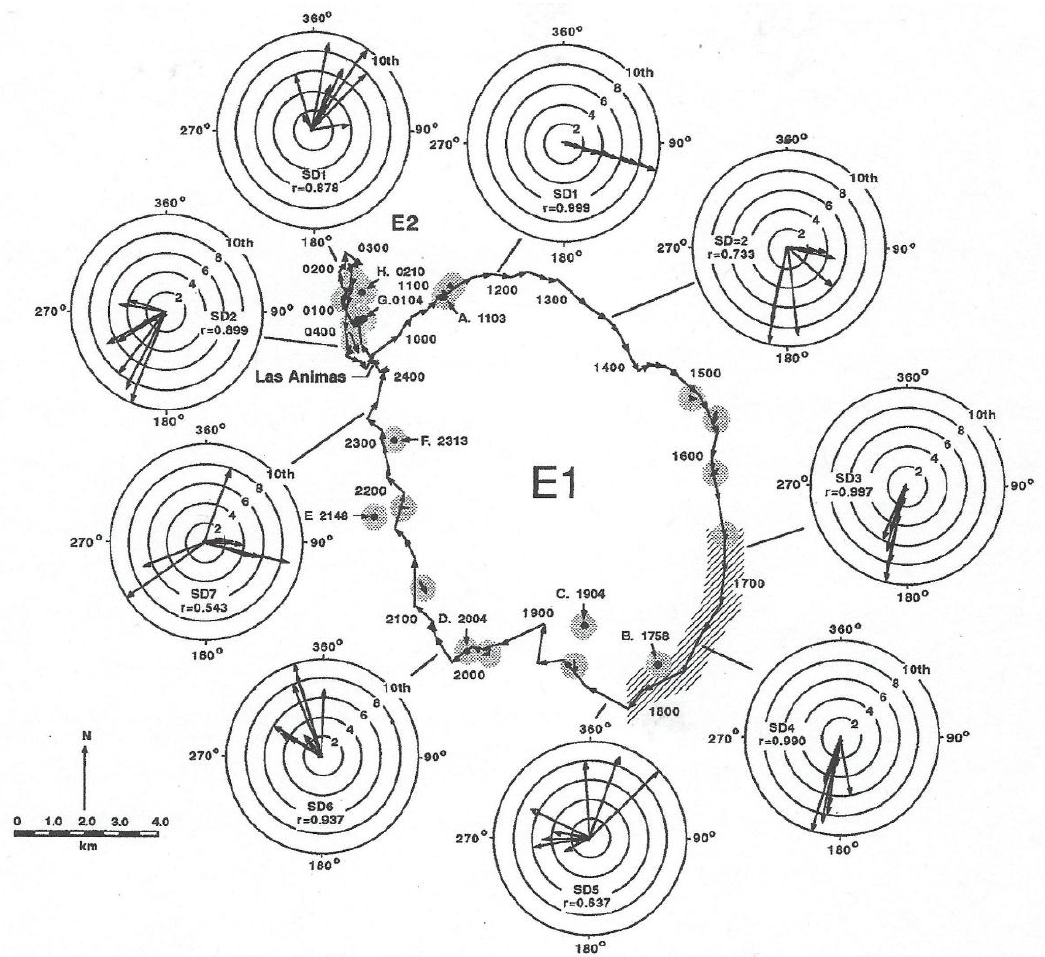
Figure 9. Two homing movements of a 125 m total length (TL) female to Las Animas Island in the Gulf of California on 29 and 30 July 1988. Movement of surface water is indicated by length of arrows in stippled areas between successive positions of a drifter released near the shark. Depth profiles or irradiance and temperature were made at locations identified by letter and time of day (hours).